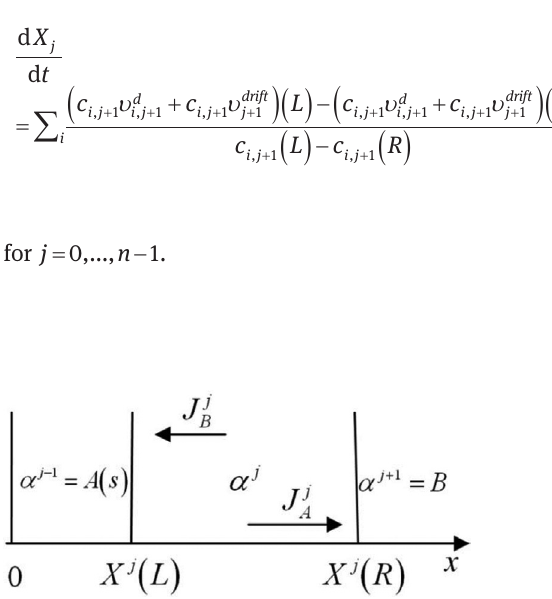
Fig. 2: The schematic presentation of the generalized Darken method.